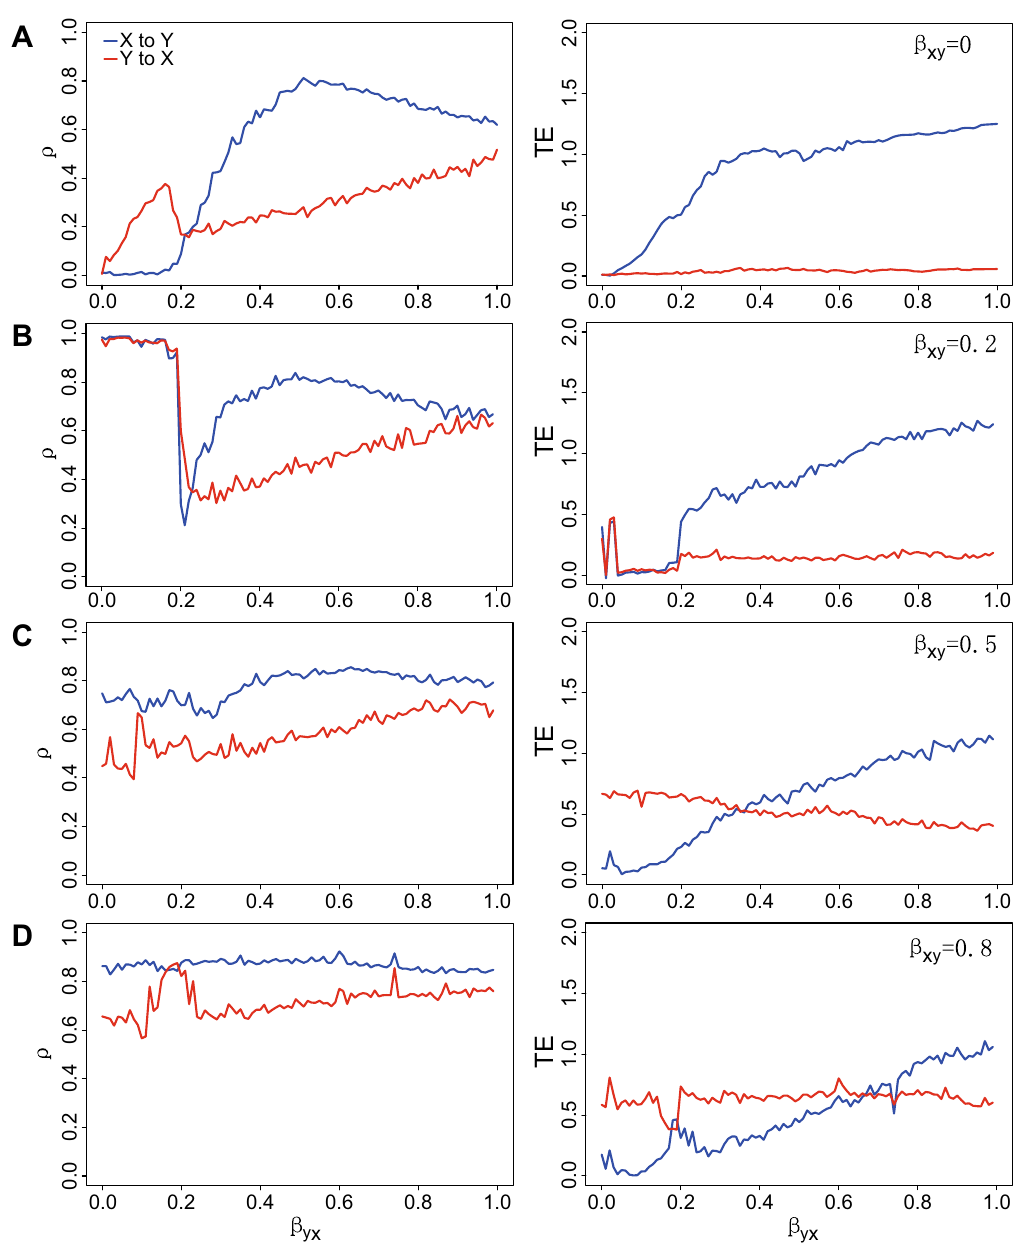
Figure 2. Inferred predictable causality via CCM and TE for embedded true causality. CCM correlation coefficient ( ρ , left plots) and Transfer Entropy (TE, right plots) are shown for the bio-inspired mathematical model in Eq. (1) representing bidirectional interactions. The mathematical model indicated as S( β xy , β yx ) is simplified as a univariate function because β xy is fixed while β yx is free and varying within the range [0, 1]. β xy and β yx are establishing true causality while ρ and TE are indicators of predictable causality. Y’s causal effects on X is theoretically fixed as a stable value corresponding to each β xy . The greater β xy the stronger Y affects X (estimated by ρ yx and TE yx in red lines). ( A ) β xy = 0 means that Y does not affect X and then X dynamics is only related to stochastic dynamics due to birth-death process as in the model (Eq. 1). X’s effects on Y depends on the value of β yx , theoretically leading to increasing functions ρ xy and TE xy (blue lines) when β yx increases; ( B ) β xy = 0.2 ; ( C ) β xy = 0.5 ; and ( D ) β xy = 0.8